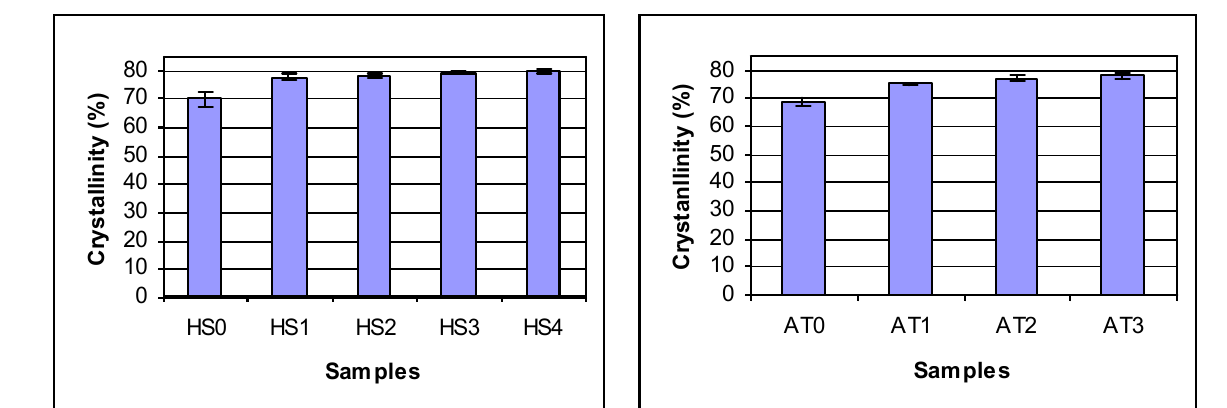
Figure 2. The crystallinities of deacetylated chitosans. Statistics analysis shows for AgraTech chiotsan: no difference in batches (p = 0.99) and differences between reactions (p = 0.001) by 2 Factor ANOVA. By Tukey’s HSD test: ATO is different from all others, AT1 and AT3 different, AT1 and AT2 are not different and AT2 and AT3 are not different; For HS chitosan, there are differences due to reaction time (p = 0.0001) by 2 Factor ANOVA. By Tukey's HSD test: HS0 is different from all others. All others are the